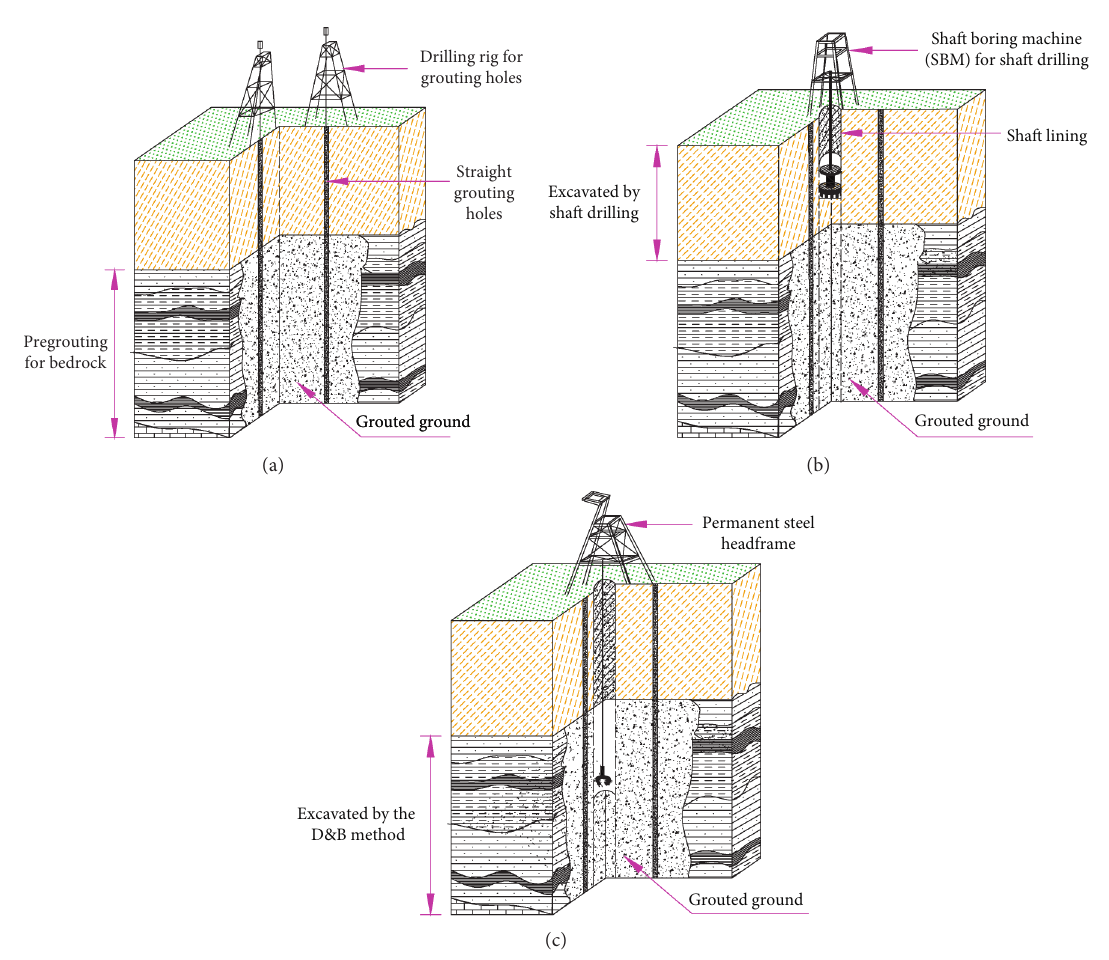
Figure 2: Traditional procedure for shaft sinking by pregrouting and shaft drilling. (a) Pregrouting from the surface is conducted first. (b) Shaft drilling. (c) Bedrock is excavated by the traditional D&B method.